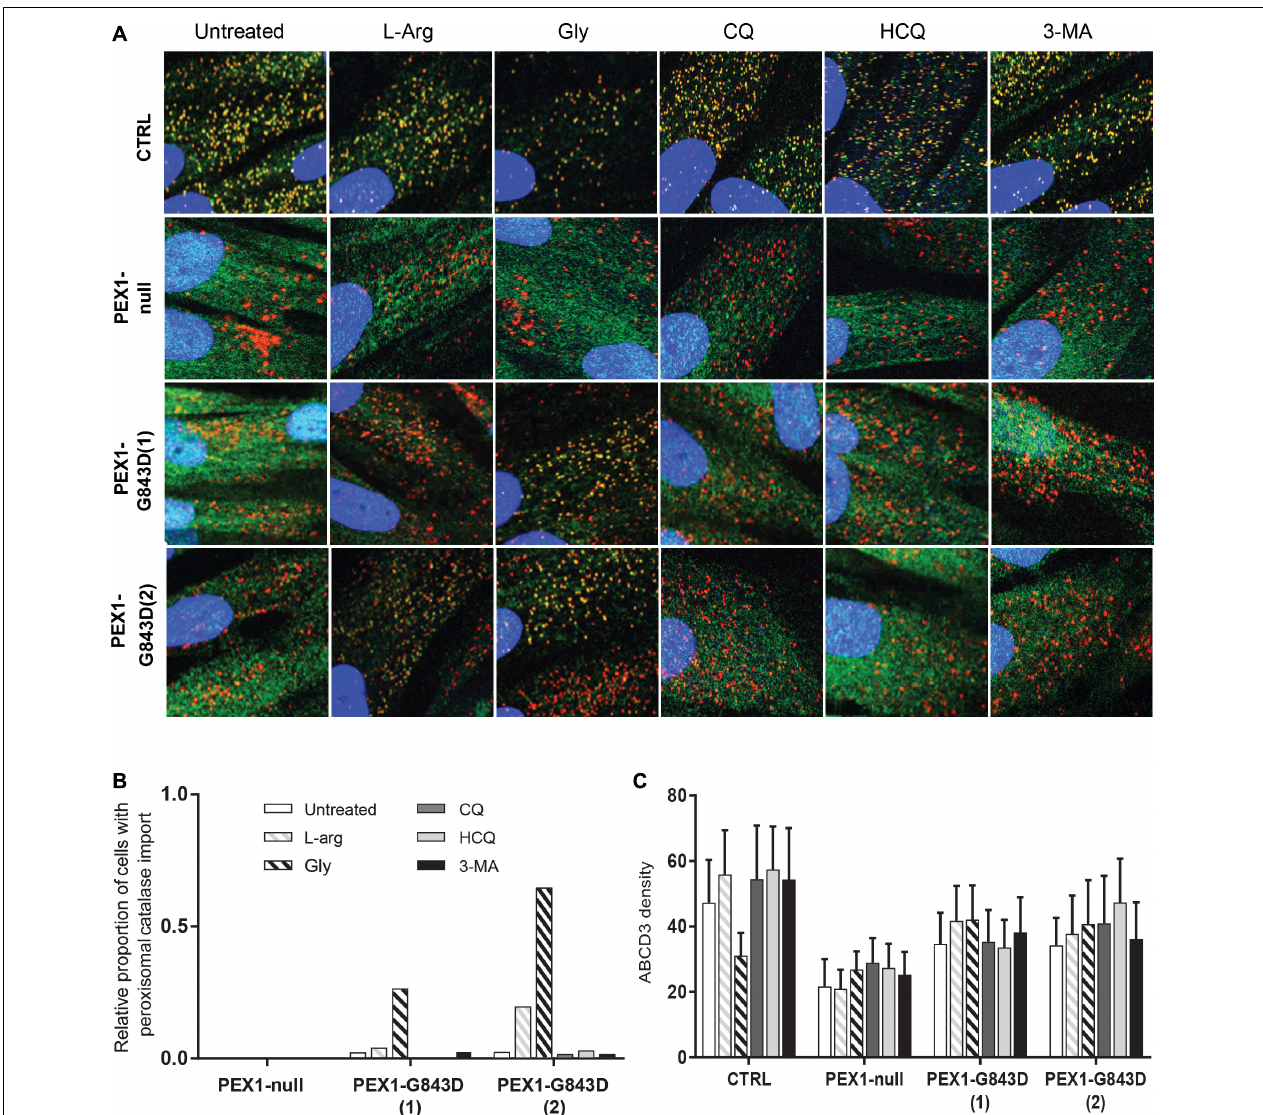
FIGURE 1 | Autophagy inhibitors do not restore import of peroxisomal catalase in primary PEX1-G843D fibroblasts. (A) Immunofluorescence microscopy in primary fibroblasts from a control individual (CTRL), a PBD-ZSD patient without residual PEX1 function (PEX1-null) and two PBD-ZSD patients homozygous for the PEX1-G843D mutation (PEX1-G843D(1) and PEX1-G843D(2)). Cells were incubated with 20 mM L-arginine (L-Arg), 5% glycerol (Gly), 10 µ M chloroquine (CQ), 10 µ M hydroxychloroquine (HCQ) or 10 mM 3-methyladenine (3-MA) for 7 days, before determining the subcellular localization of the peroxisomal matrix protein catalase (green signal) and the peroxisomal membrane protein (PMP) ABCD3 (red signal). Shown are representative images, each image representing a section of 40 × 40 µ m. The nuclei were stained with DAPI (blue signal). (B) Quantification of primary fibroblasts, treated as described in A, which display peroxisomal catalase import as determined by immunofluorescence microscopy ( > 60 cells analyzed for each condition). Control fibroblasts showed 100% peroxisomal catalase import under all conditions (set as 1.0). (C) Density of punctated ABCD3-containing structures (indicating peroxisomal membranes) per cell area as determined by immunofluorescence microscopy in primary fibroblasts treated as described in A (see section “Materials and Methods” for more details). Data presented as mean of n > 40 cells + SD. Statistical analyses of treated versus untreated cells were performed using Mann-Whitney U tests and revealed no statistically significant